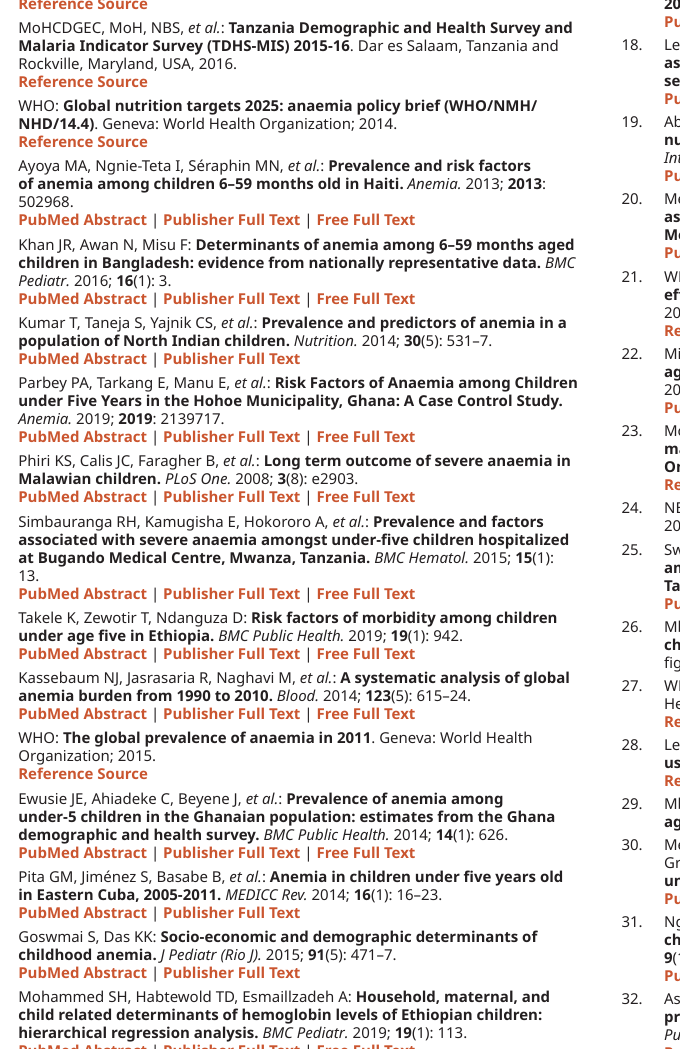
figshare; 2020. 27. WHO: Global nutrition targets 2025: breastfeeding policy brief. World Health Organization, 2014. Reference Source 28. Leroy JL: ZSCORE06: Stata module to calculate anthropometric z-scores using the 2006 WHO child growth standards. 2011. Reference Source 29. Mboya IB, Mamseri R, John B, et al. : Anaemia in children under five years of age in rural Tanzania. V1 ed: Harvard Dataverse;